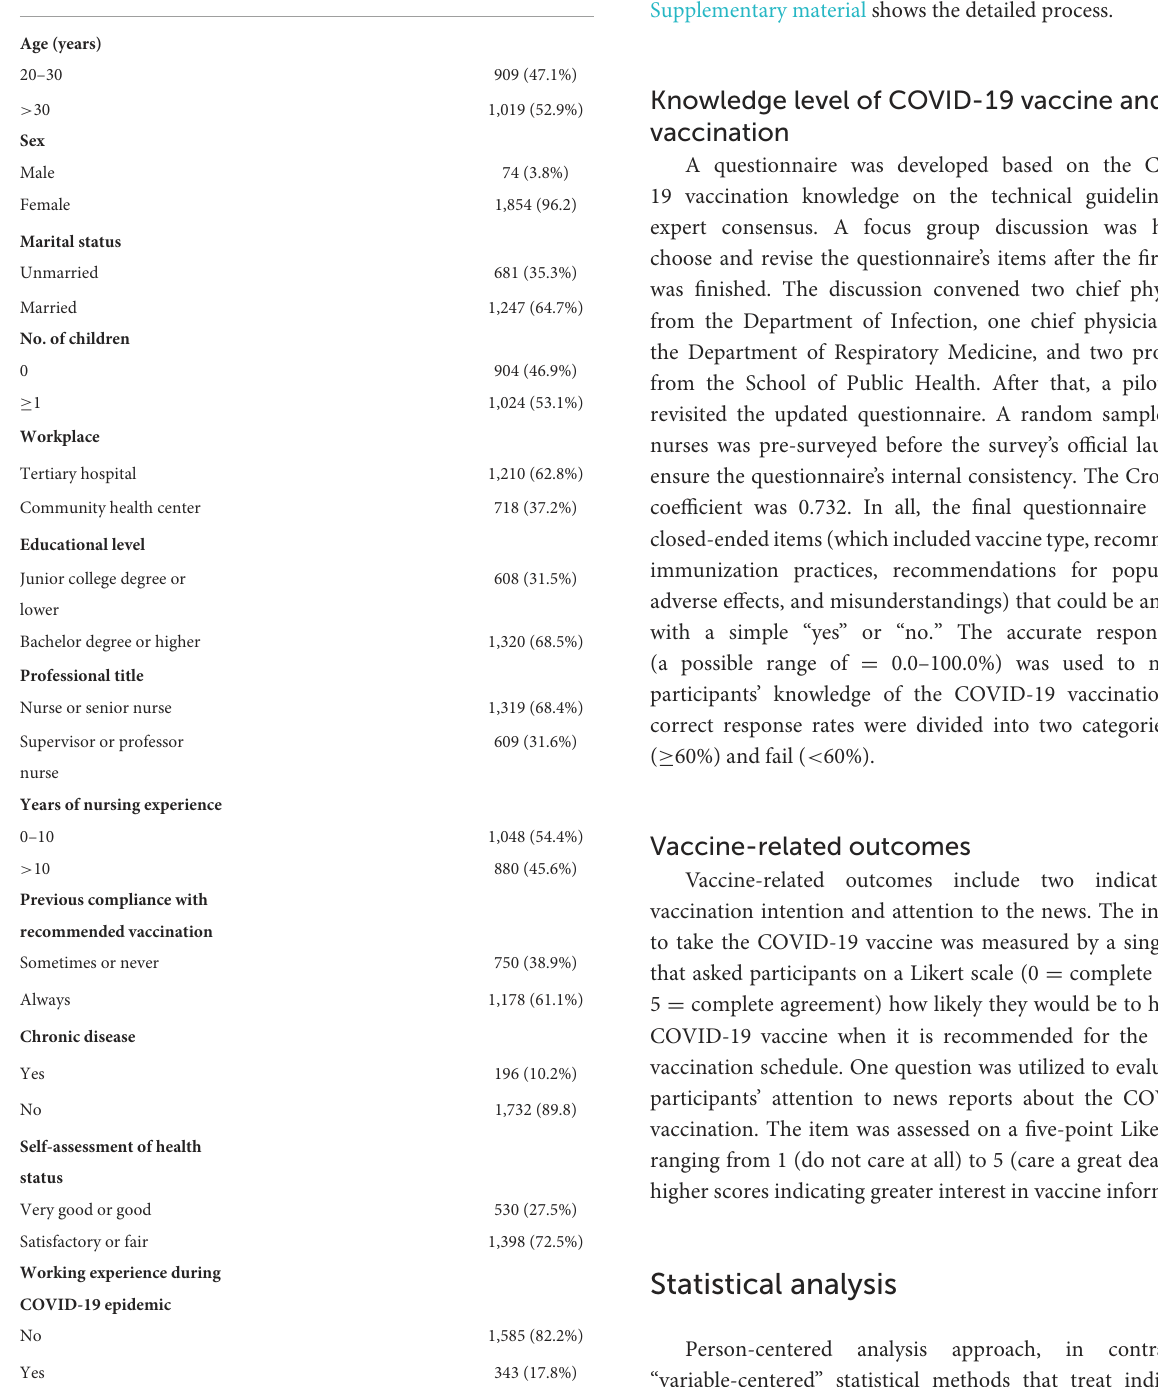
TABLE 1 Demographic characteristics of the participating nursing staff ( N =